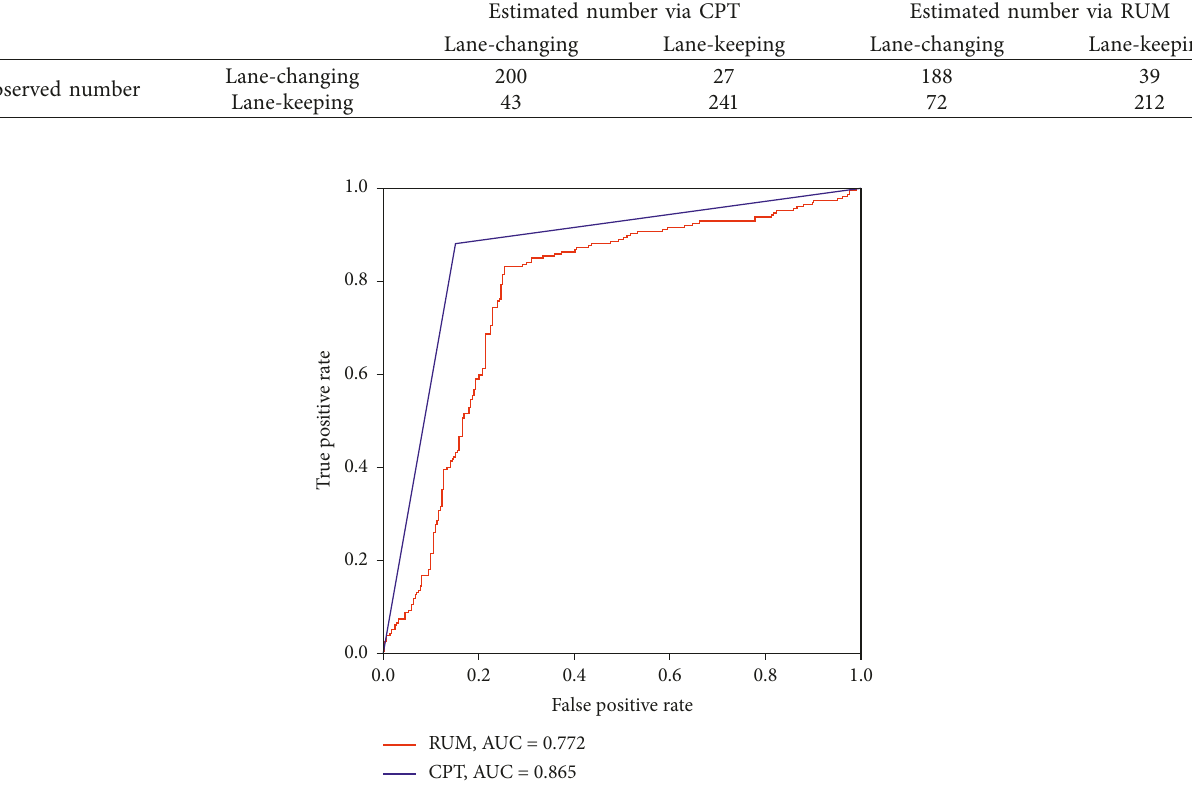
Figure 6: Receiver operating characteristic